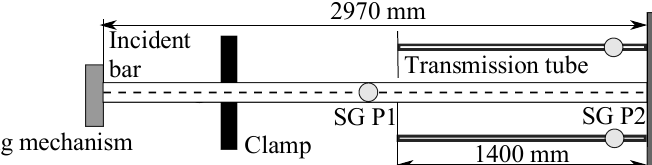
Figure 5 : Schematic representation of the torsional split Hopkinson bar apparatus. 𝜃̇ = 𝑇 𝑖 (𝜏)−𝑇 𝑟 (𝜏) 𝑖 (𝑝𝐽𝑐)